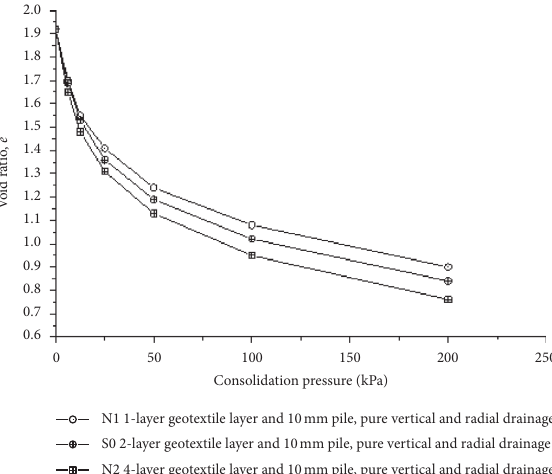
Figure 11: Curves of void ratio versus consolidation pressure for tests of Group C (N1, S0,